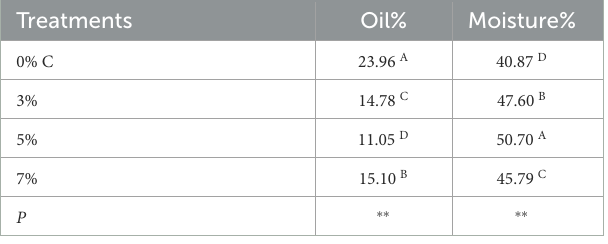
TABLE 1 Oil and moisture contents of different levels of orange-albedo powder as coating films for deep-fried falafel balls. Treatments